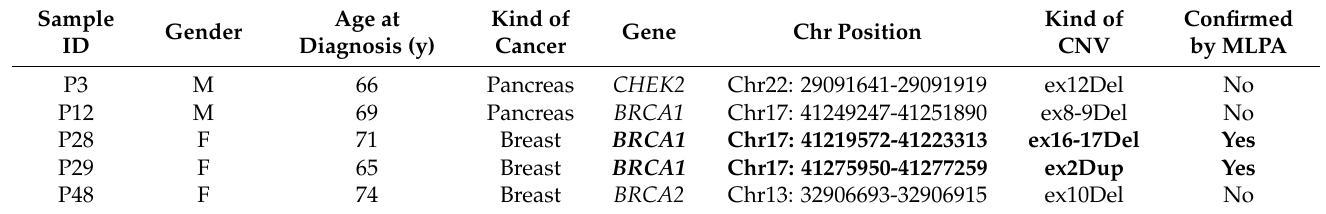
Table 3. Full list of copy number variants identified in each analyzed patient based on bioinformatic software prediction. Variants confirmed after MLPA validation are reported in